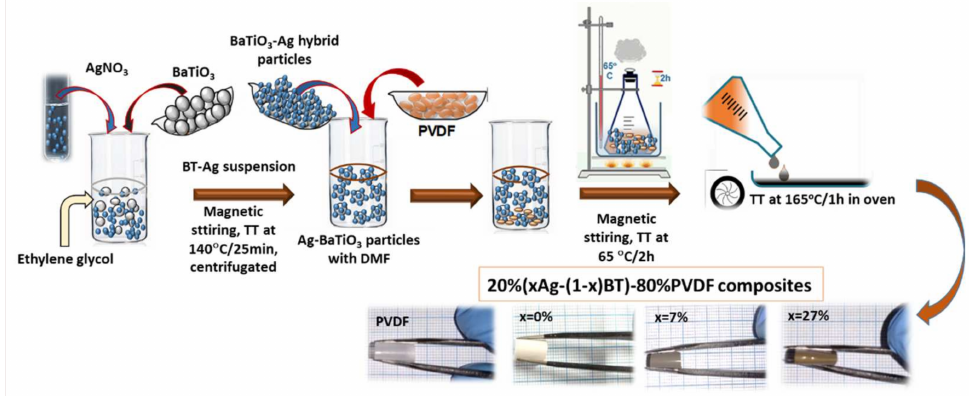
Figure 1. Preparation workflow for the 20%( x Ag − (1 − x )BT) − 80%PVDF flexible